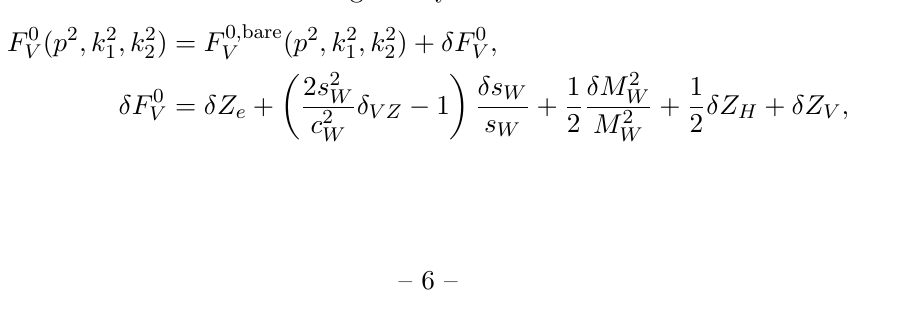
Figure 2 . Feynman diagrams for vertex corrections from dark fermions to h (center), and h